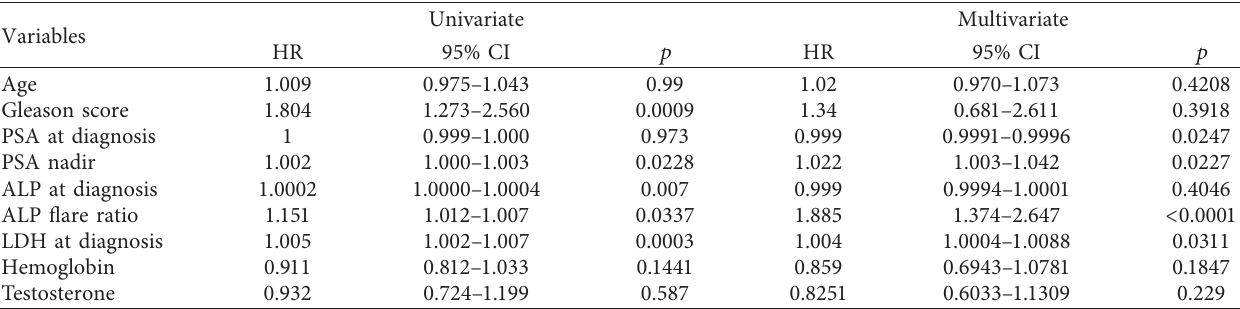
Supplementally Figure 1: Kaplan–Meier curves showing progression-free survival (PFS) after starting ADT with